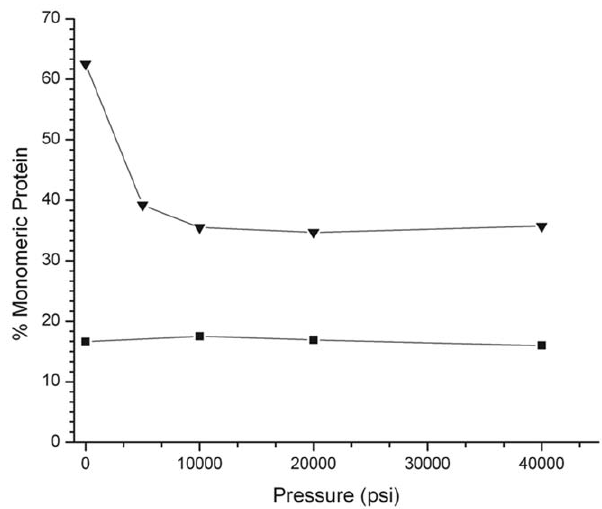
Figure 6. Effect of elevated pressure and temperature on the reversal of intermolecular protein cross-links in lysozyme FFPE tissue surrogates. The tissue surrogates from figure 5 were incubated in 50 mM Tris-HCl buffer, pH 4 with 2% SDS and 0.1 M glycine at100 u C for 2 h at pressures ranging from atmospheric pressure (14.7 psi) to50,000 psi buffer at100 u C for 2 h at pressures ranging from atmospheric pressure (14.7 psi) to 50,000 psi. The heated treated tissue surrogate samples were separated by 1-D SDS-PAGE. Pressure values are shown at the top of each gel lane.